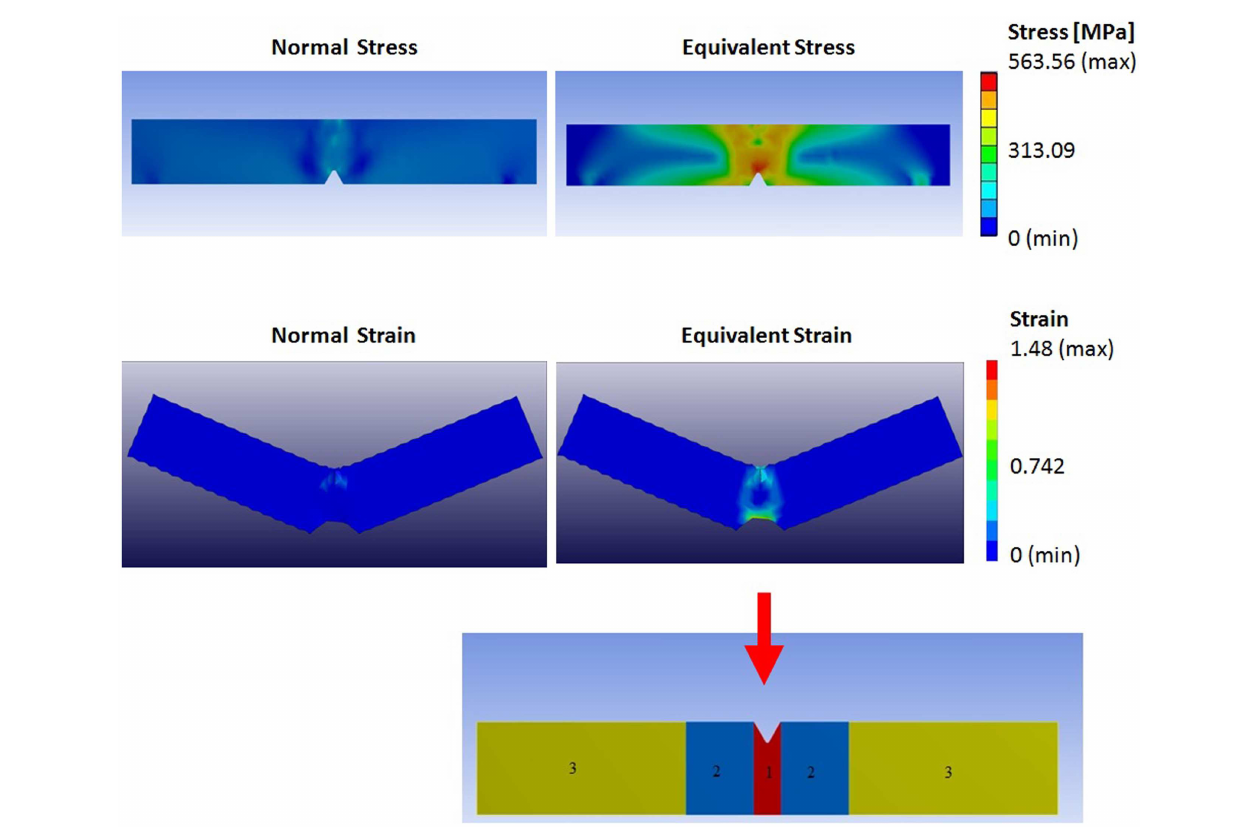
FIGURE 4 |A material-independent FE simulation of impact loading demonstrating the typical distribution of normal and equivalent stress-strain fields (above the arrow), and the corresponding division of sample geometry based on stress intensities within the sample (Onal et al., 2014)